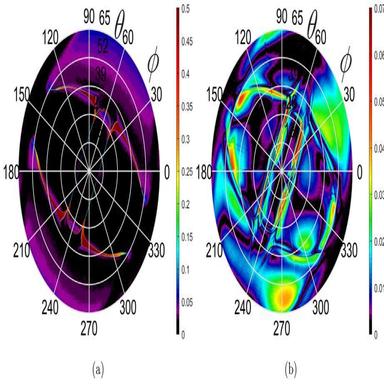
Difference TOF P-UPS (a) and Difference amplitude P-UPS (b) between the experimental polar plot for a unidirectional 4 carbon/epoxy plate and the forward simulations based on the results of the inversion procedure. The TOF colorbar is represented in μs. The amplitude colorbar is normalized to the maximum amplitude of the input signal.